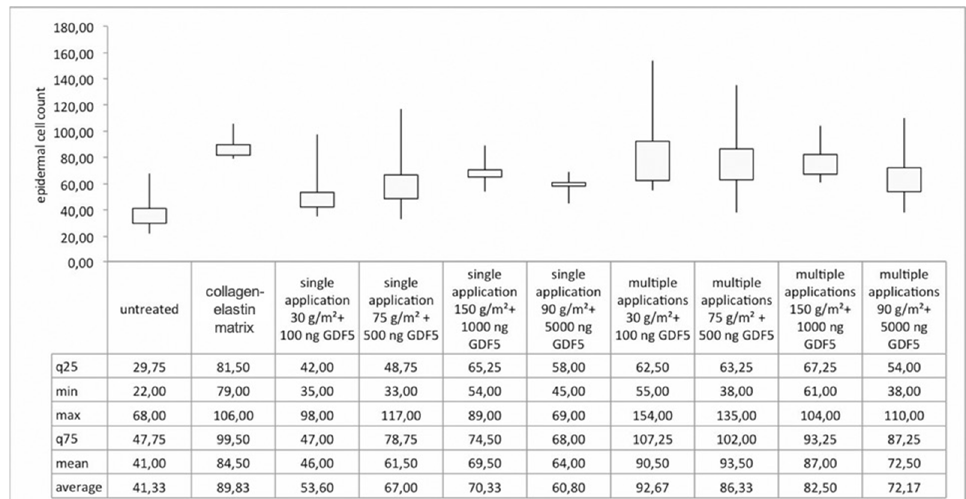
Figure 4. Histological analysis of the epidermal cell density. The epidermal cell density was histologi- cally evaluated within a section of 100 µ m width from the former sore center of the epidermis. All images per sample were taken from three different